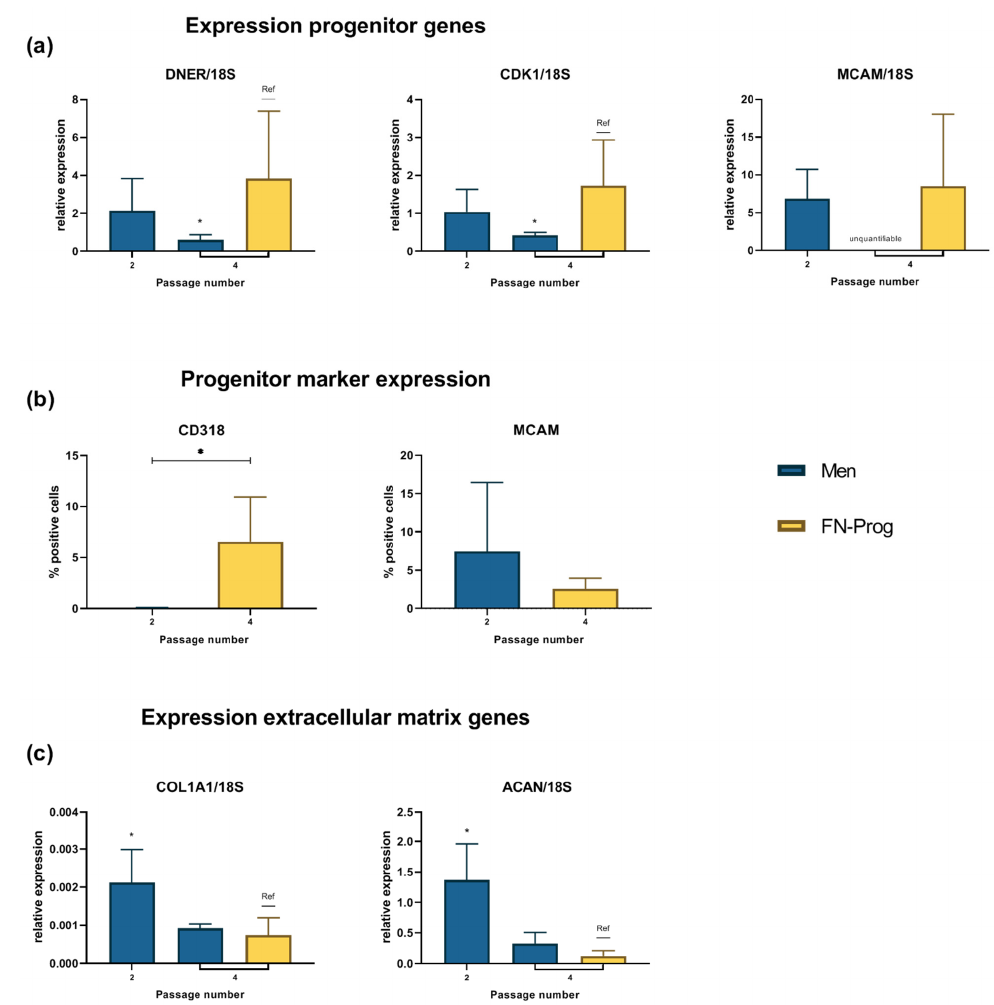
Figure 3. Expression of ( a ) genes associated with meniscus extracellular matrix production and ( b ) meniscus progenitor phenotype as measured by quantitative real-time PCR and ( c ) progenitor marker expression measured using flow-cytometry after monolayer expansion. n = 5 donors per group per condition. ACAN , aggrecan; COL1A1 , collagen type I alpha 1 chain; CDK1 , Cyclin-dependent kinase 1; DNER , Delta and Notch-like epidermal growth factor-related receptor; FN-prog, fibronectin selected cells; MCAM , Melanoma cell adhesion molecule; Men, total meniscus population * p < 0.05; ref, reference